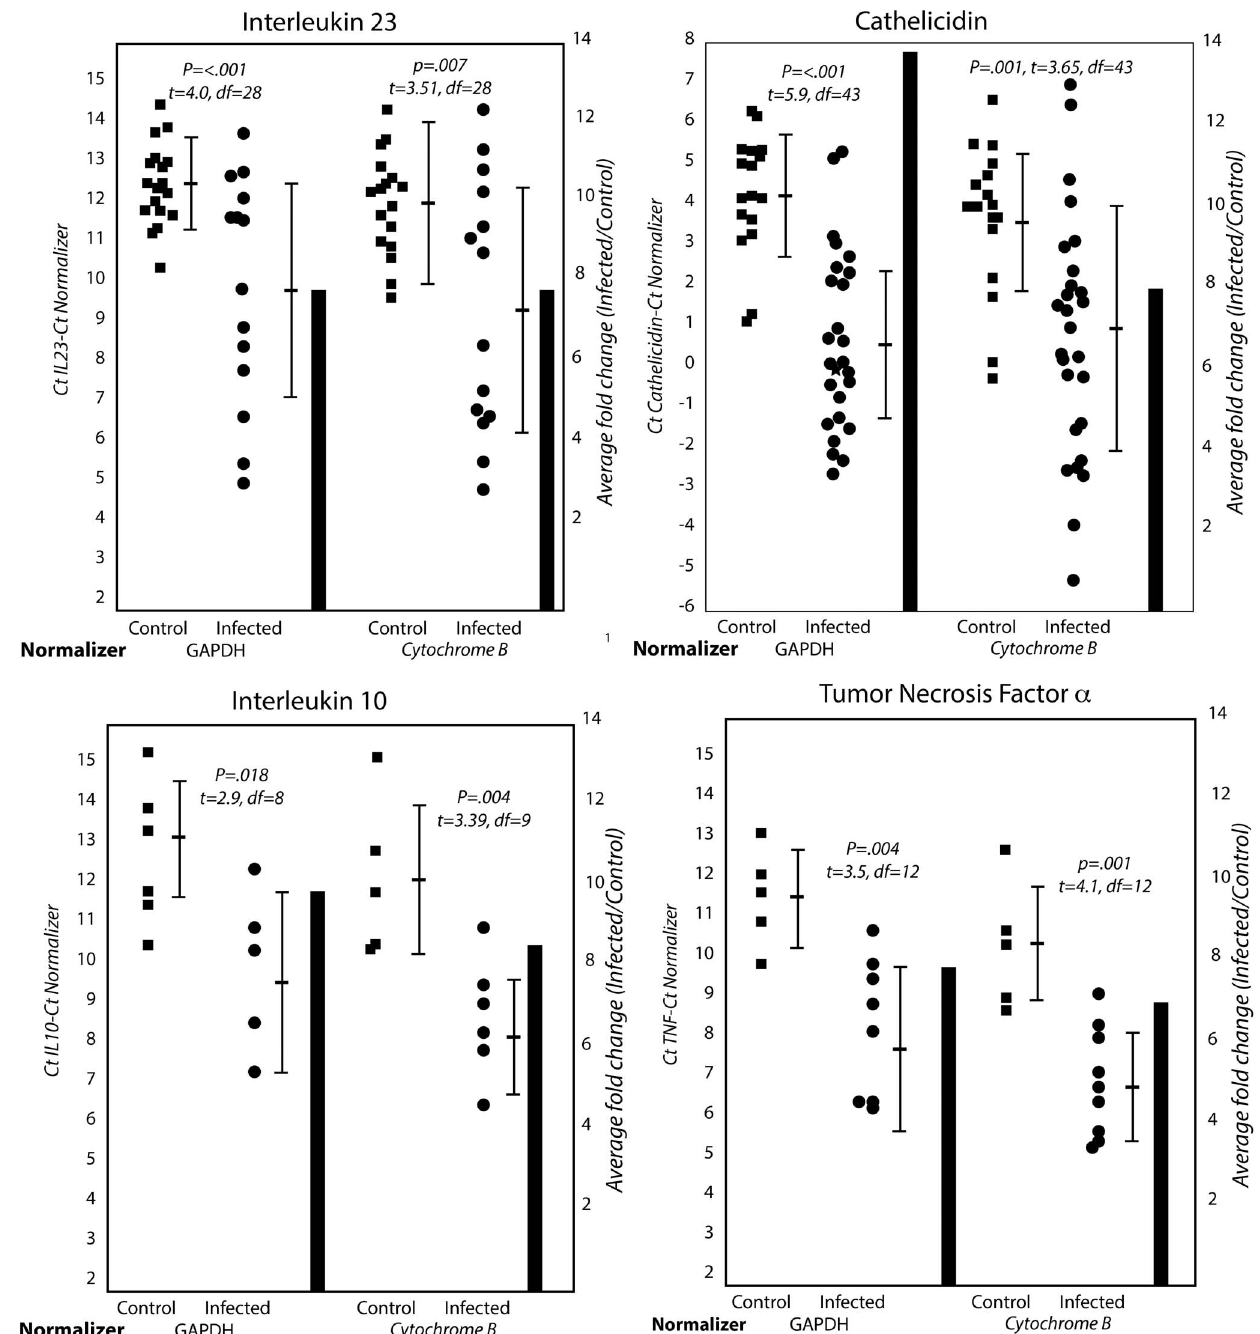
Figure 1. Differences in levels of transcripts for IL23, IL10, Cathelicidin and TNF a in lungs of hibernating mock-infected (control) or P.destructans -infected bats. Each square (control) or dot (infected) represents the value from a bat. The relative levels of a transcript for each bat are depicted as Cycle threshold (Ct) normalized separately ( D Ct) for levels of transcripts for two ‘‘house-keeping genes – Glycerol 6 phosphate dehydrogenase (GAPDH) and Cytochrome B. The horizontal bar represents the mean while the vertical bar indicates standard deviation from the mean. Significance (P), test statistics (t) and degrees of freedom (df) are indicated. A lower value of one (1) D Ct (or Ct) indicates approximately a two- fold higher concentration of RNA. Infected bats as a group had lower D Ct values for the four genes. The histograms represent fold differences between infected and control bats. Only results from reactions that yielded unambiguous results (products of the expected size and sequence, homogenous denaturation profiles, no products for no-template controls) were used for analysis. The number of results that fitted these criteria for each analysis were: IL23 - Control =17, Infected =13; Cathelicidin – Control =17, Infected =28; IL10 – Control =5, Infected =6; TNF a – Control =5, Infected =9.